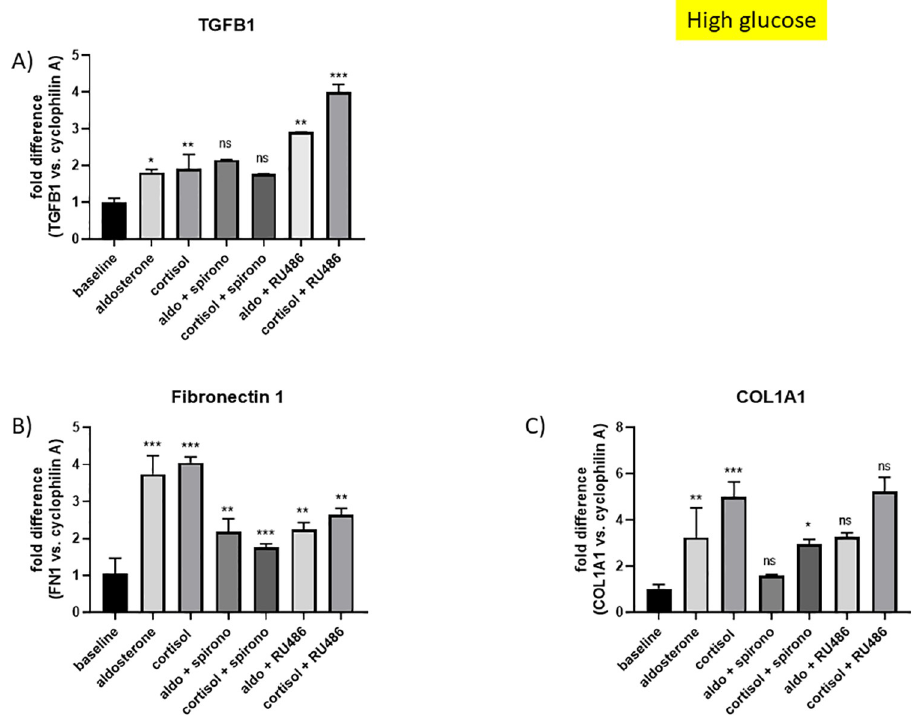
Fig 7. mRNA expression of TGFB1, FN1 and COL1A1 in HRMC upon aldosterone and cortisol stimulation with and without MR and GR inhibition in high glucose conditions. A) mRNA expression of TGFB1 in HRMC. Baseline was EtOH. Fold difference is shown with cyclophilin A as endogenous control. Aldosterone ( � p = 0.015) and cortisol ( �� p = 0.004) significantly upregulated TGFB1 mRNA expression. The upregulation of TGFB1 by aldosterone and cortisol could not be changed with spironolactone (Aldo vs. Aldo + spironolactone: ns; cortisol vs. cortisol + spironolactone: ns). The combination Aldo + RU486 ( �� p = 0.002) and cortisol + RU486 ( ��� p < 0.0001) stimulated TGFB1 expression more than Aldo and cortisol alone. B) mRNA expression of FN1 in HRMC. Baseline was EtOH. Fold difference is shown with cyclophilin A as endogenous control. Aldosterone ( ��� p < 0.0001) and cortisol ( ��� p < 0.0001) significantly upregulated FN1 mRNA expression up to 4-fold. The upregulation of FN1 by aldosterone and cortisol could significantly be reduced by spironolactone (Aldo vs. Aldo + spironolactone: �� p = 0.002; cortisol vs. cortisol + spironolactone: ��� p < 0.0001). RU486 was also able to reduce the upregulation of FN1 by aldosterone and cortisol. Aldo vs. Aldo + RU486 ( �� p = 0.002) and cortisol vs. cortisol + RU486 ( �� p = 0.004). C) mRNA expression of COL1A1 in HRMC. Baseline was EtOH. Fold difference is shown with cyclophilin A as endogenous control. Aldosterone ( �� p = 0.006) and cortisol ( ��� p < 0.0001) significantly upregulated COL1A1 mRNA expression.